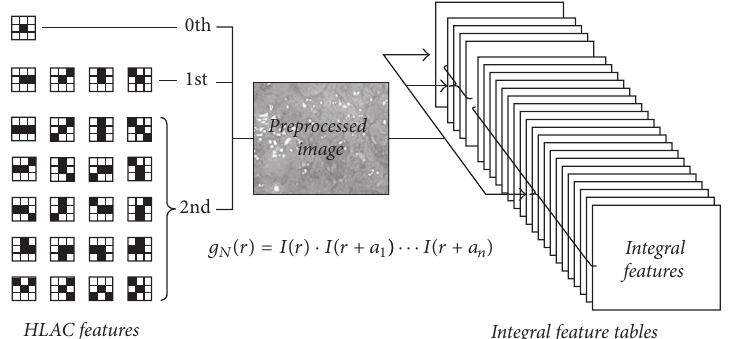
Figure 8: Integral feature extracting using HLAC masks.